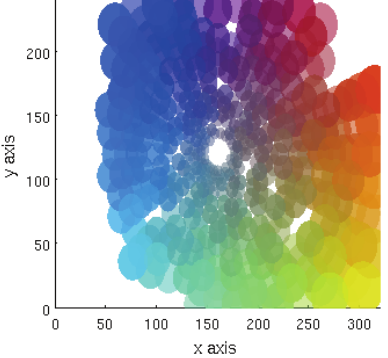
the full scope of what can be learnt from the visual targets available. The scale on the two maps are the same, so the di(cid:636)erence between them illustrates the additional coverage obtained when three targets are available and spread out across the visible space. The reason for the restriction, caused by only having a single target available to